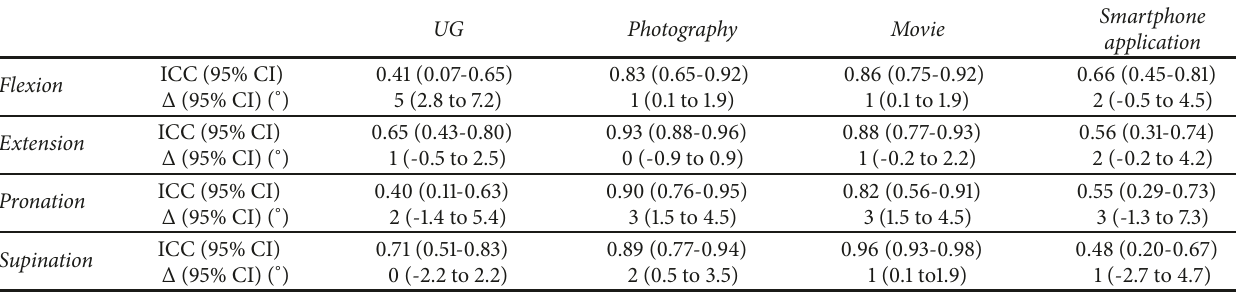
Table 2: Interobserver reliability (ICC) and mean difference ( (cid:2) ) and 95% CI (in degrees) of UG, photography, and movie and smartphone application measurements. UG